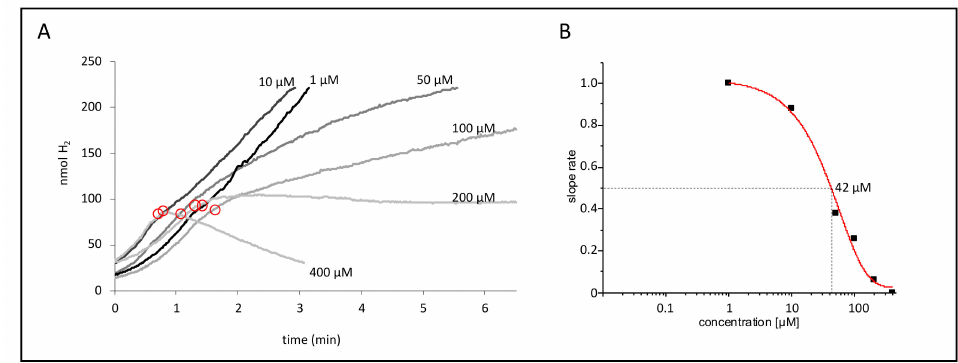
Figure 3. Dose-dependent e ff ect of CCCP. (A) Strain CP630 ( ∆ hyaB ) was used as a representative strain for CCCP inhibition after initiation of the reaction with 50 mM formate and linear slope; the designated concentrations of CCCP were added at the time points encircled in red. ( B ) The apparent EC 50 values of this set of activities were calculated from the ratio of slopes after and before CCCP addition and subsequent fitting with the EC 50 function in